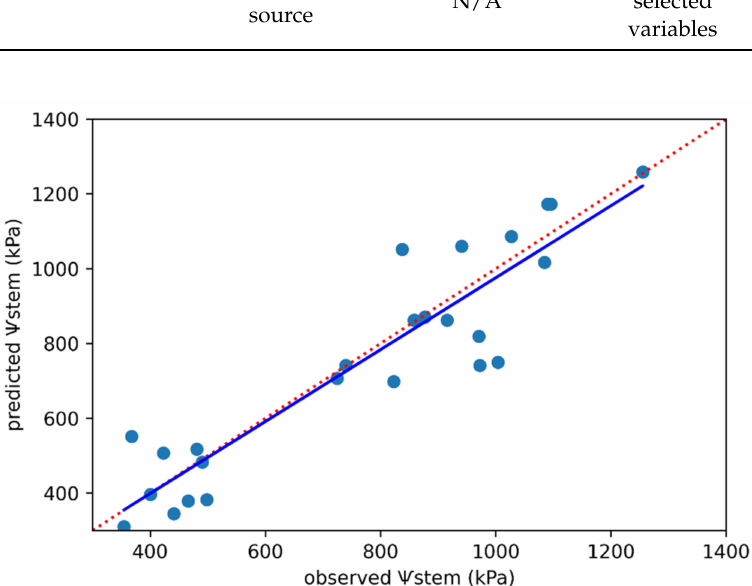
Figure 7. Scatter plots between predicted and observed Ψ stem (kPa) simulated on the test set (n = 26) using the top-performing models—partial least squares regression (PLSR) trained with simple ratio indices (SI). The blue line is the regression line, and the red dotted line is the 1:1